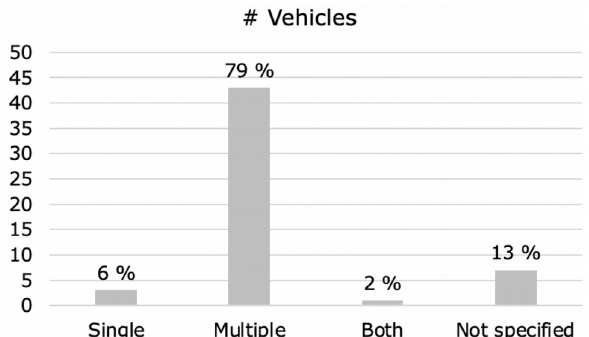
Figure 10. Statistics on supply chain structure: # vehicles